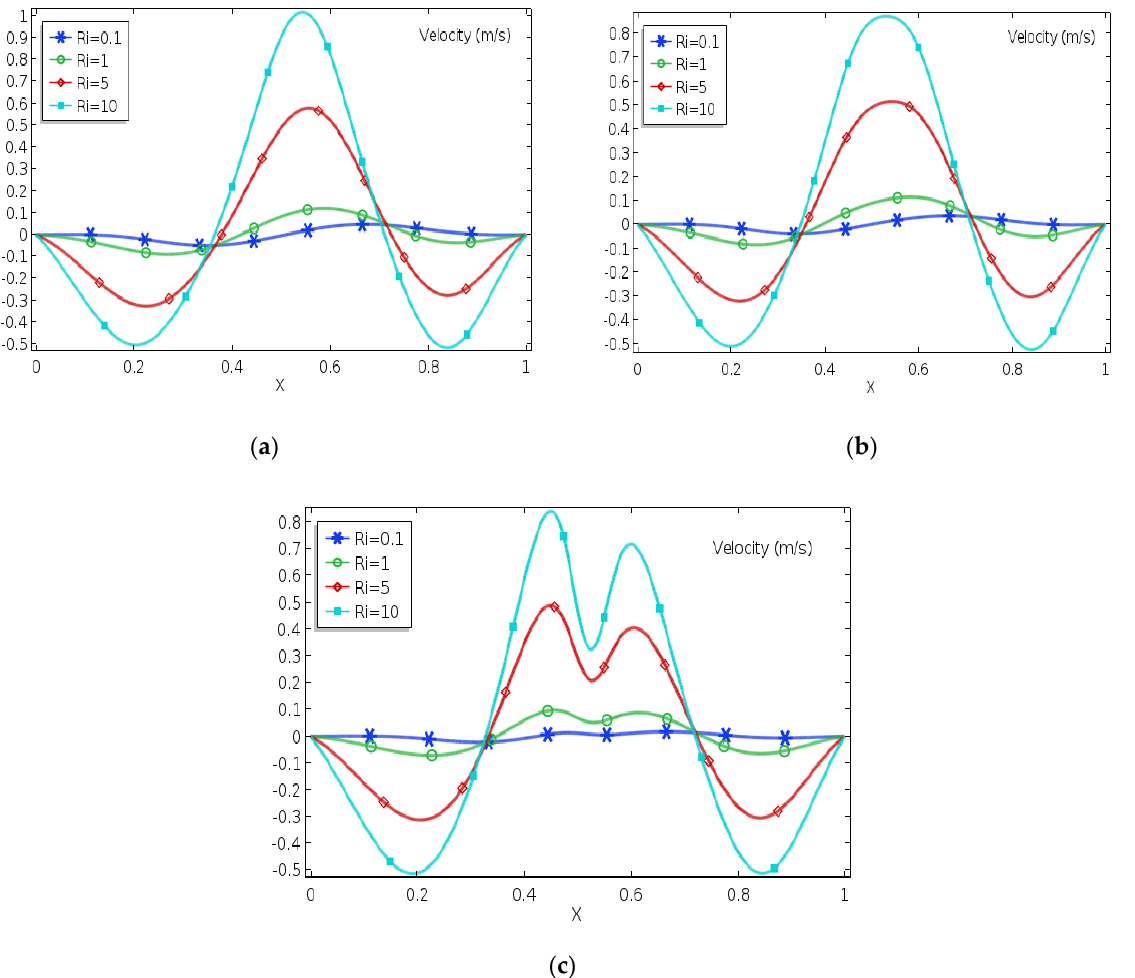
Figure 6. Velocity profiles for ( a ) L = 0.25, ( b ) L = 0.35 ( c ) L = 0.45 at Re = 100, Ha = 10, and λ =